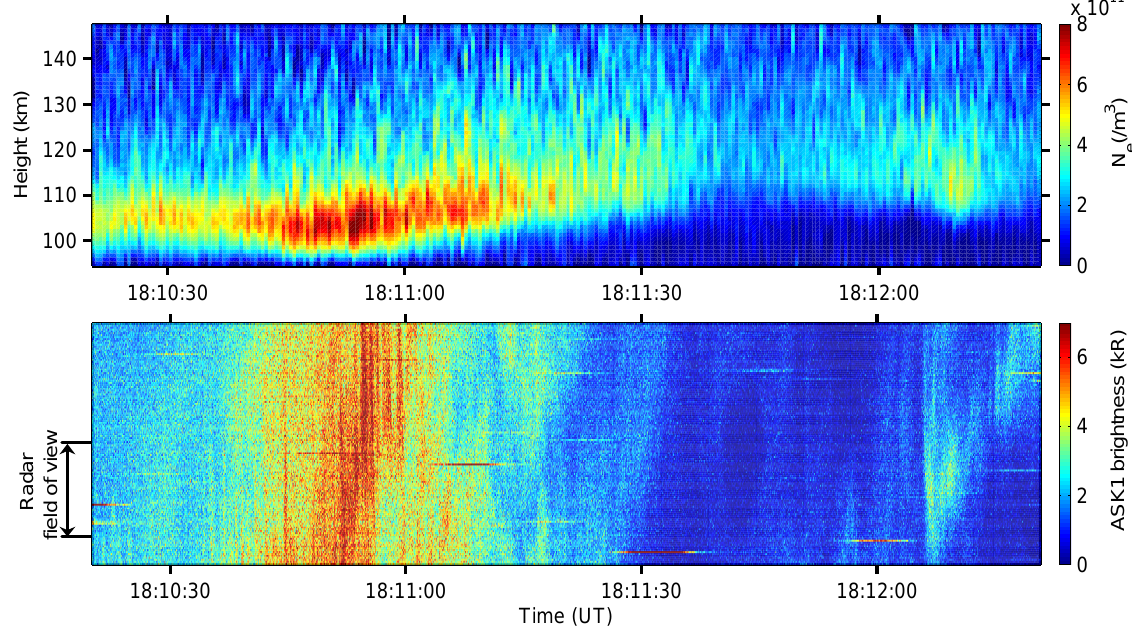
Fig. 1. Top: Electron density profiles in the E region measured with the EISCAT UHF radar. Bottom: Time series of slices through the ASK1 images in the N-S